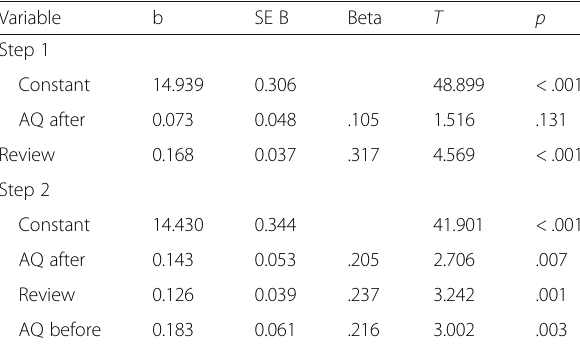
Table 7 Hierarchical regression analysis to assess the exclusive contribution of advance quizzing before learning to the prediction of “ Introduction to Memory ” exam performance